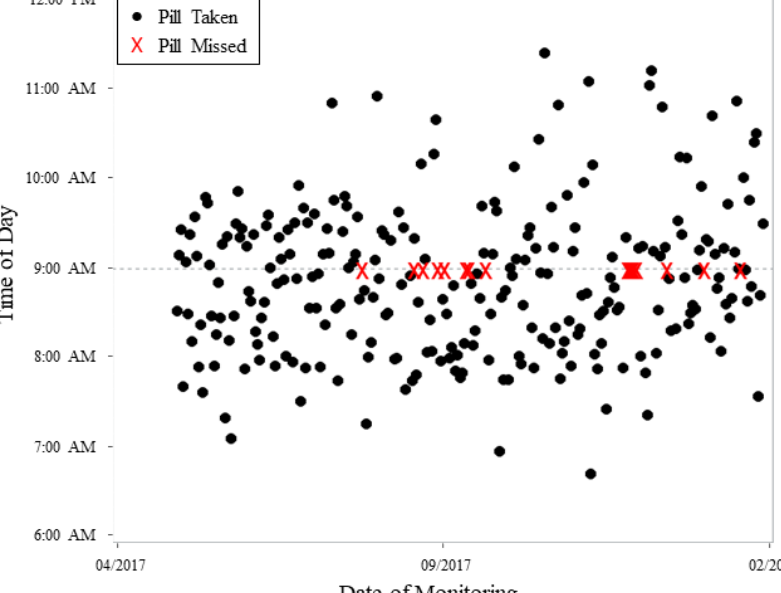
Figure 3. Time of day that medication was taken for each day over 7 months of monitoring by a participant with mild Alzheimer disease. The dots indicate the times at which the pill was taken, and an X indicates when a pill was missed. Overall, participant adherence was 94% over 9